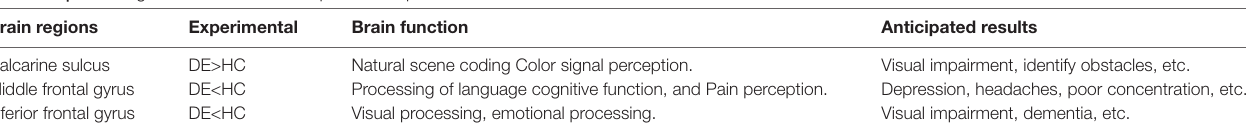
TABLE 5 | Brain regions alternation and its potential